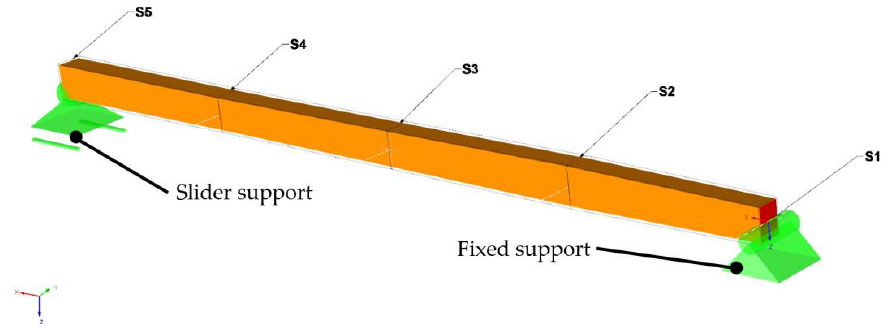
Figure 13. 3D numerical modelling of the wooden beams.